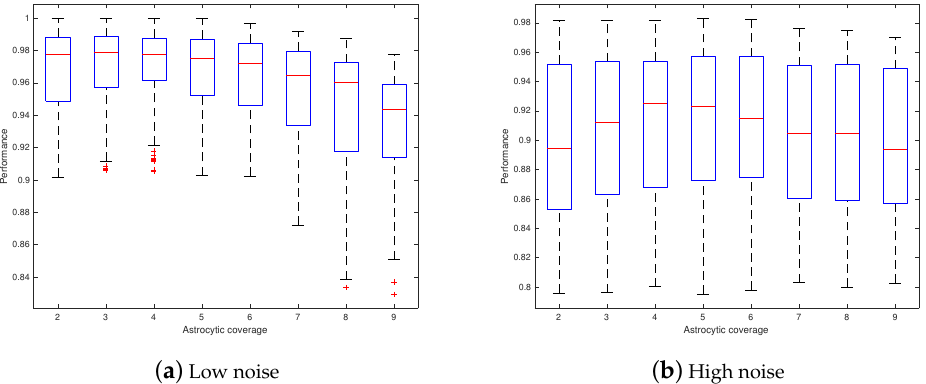
Figure 8. Short-term memory performance subject to low and high salt-and-pepper noises. The horizontal axis denotes the size of astrocytic coverage and the vertical axis denotes the performance score C p . At the low noise level, the performance starts to decrease from l = 6; at the high noise level, there does not exist a significant change in performance, although the medians are slightly different.